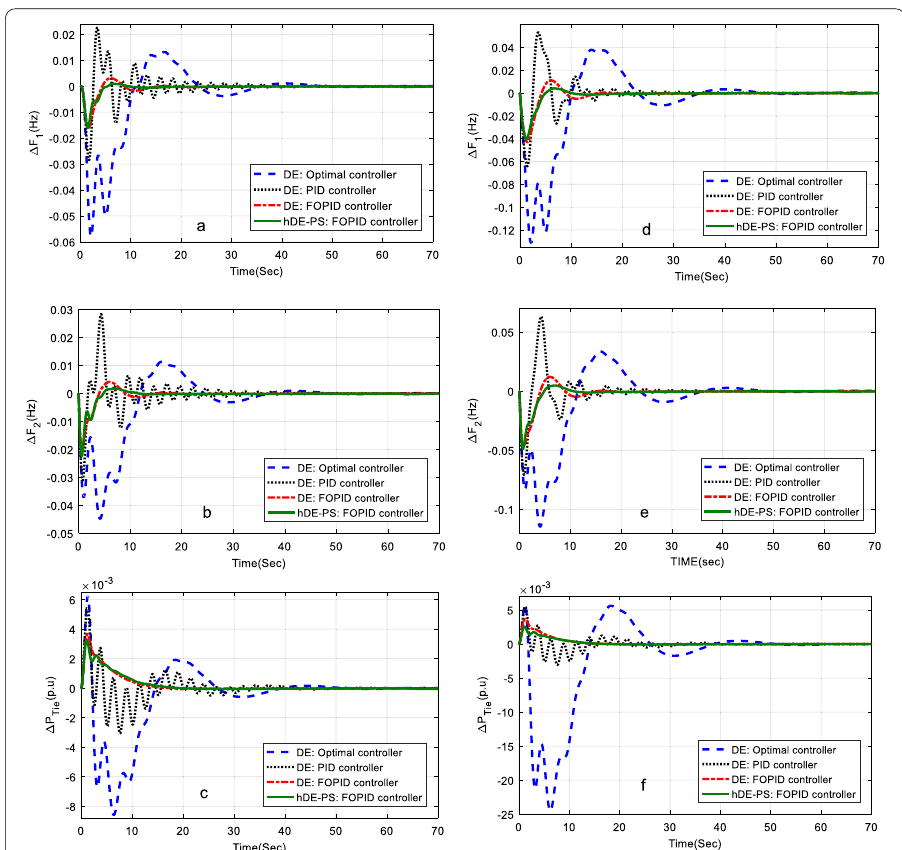
Fig. 5 System response with only AC line. a ΔF 1 , b ΔF 2 , c ΔP Tie (� P f ΔP Tie (� P D 1 = 0.01 p . u . MW & � P D 2 = 0.02 p . u . MW